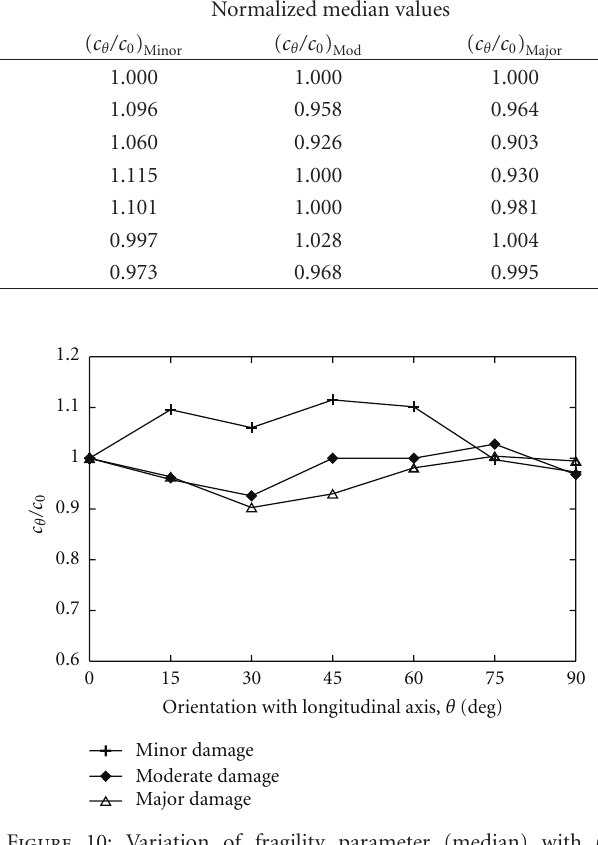
Figure 10: Variation of fragility parameter (median) with θ (case